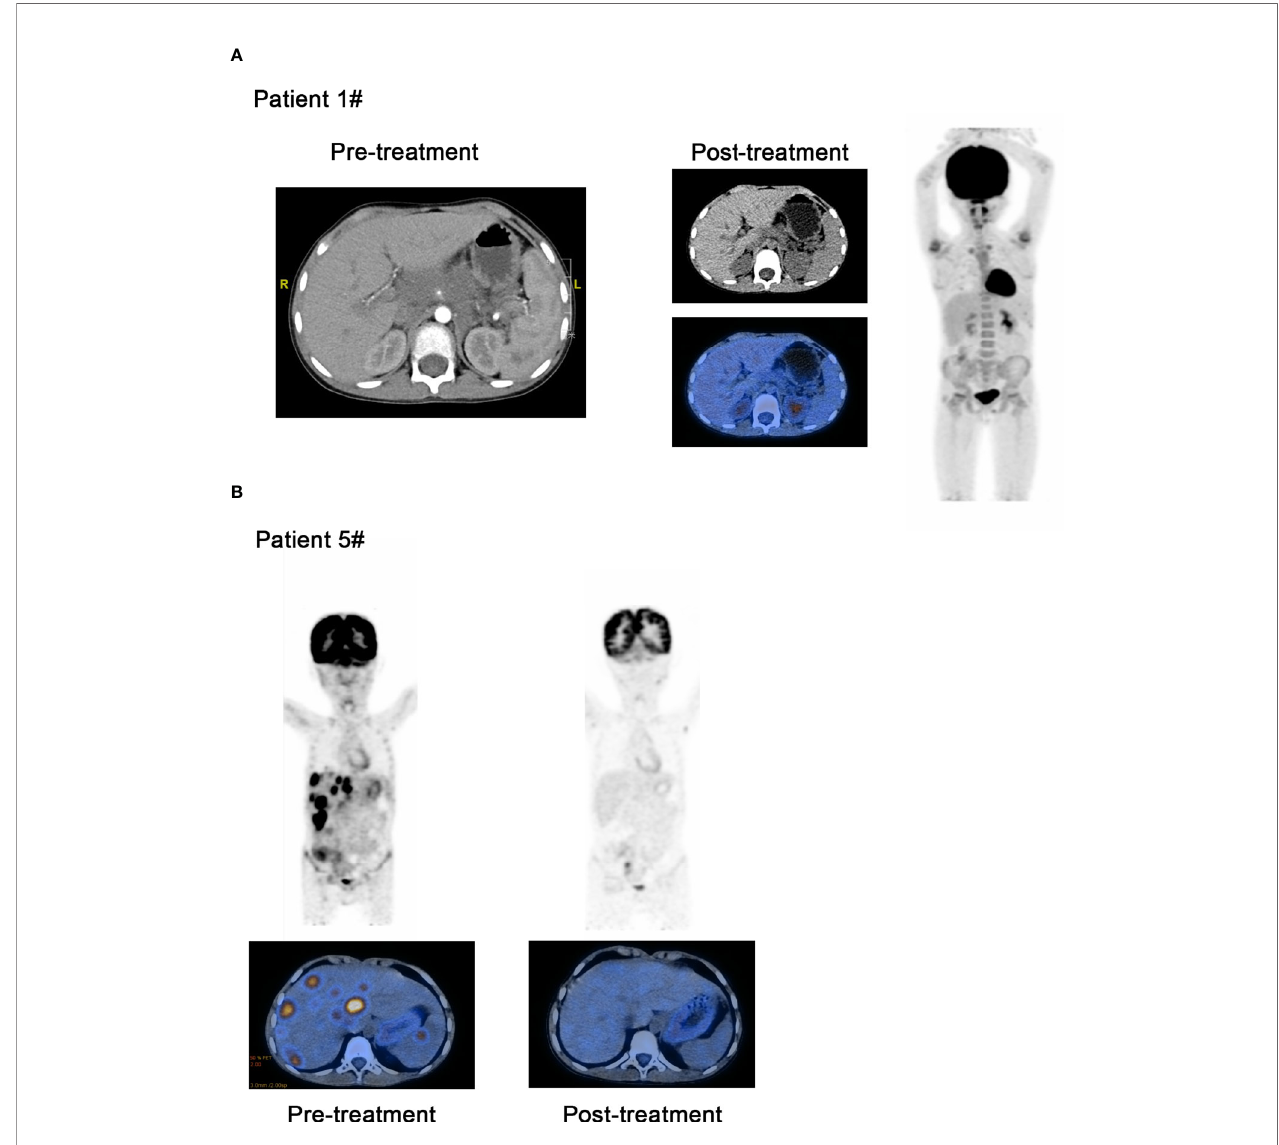
FIGURE 2 | Comparison of curative effect of patients before and after treatment through image examination. (A) Patient 1 who was diagnosed as the Hodgkin lymphoma has achieved CR and sustained remission for 6 months after PD-1 inhibitor therapy. (B) Patient #5 was also achieved CR after 6 cycles of PD-1 inhibitor therapy and did not progressed by the data